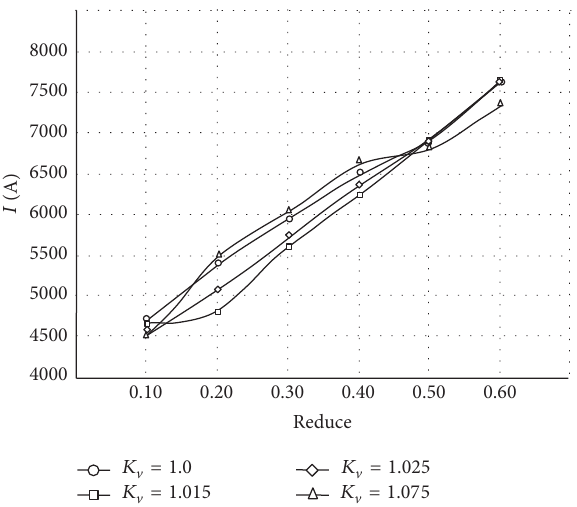
Figure 8: The calculated distributions of the moment on the detail, depending on the reduce and the speed asymmetry coefficient (the initial thickness of compact material is 0.5 mm).